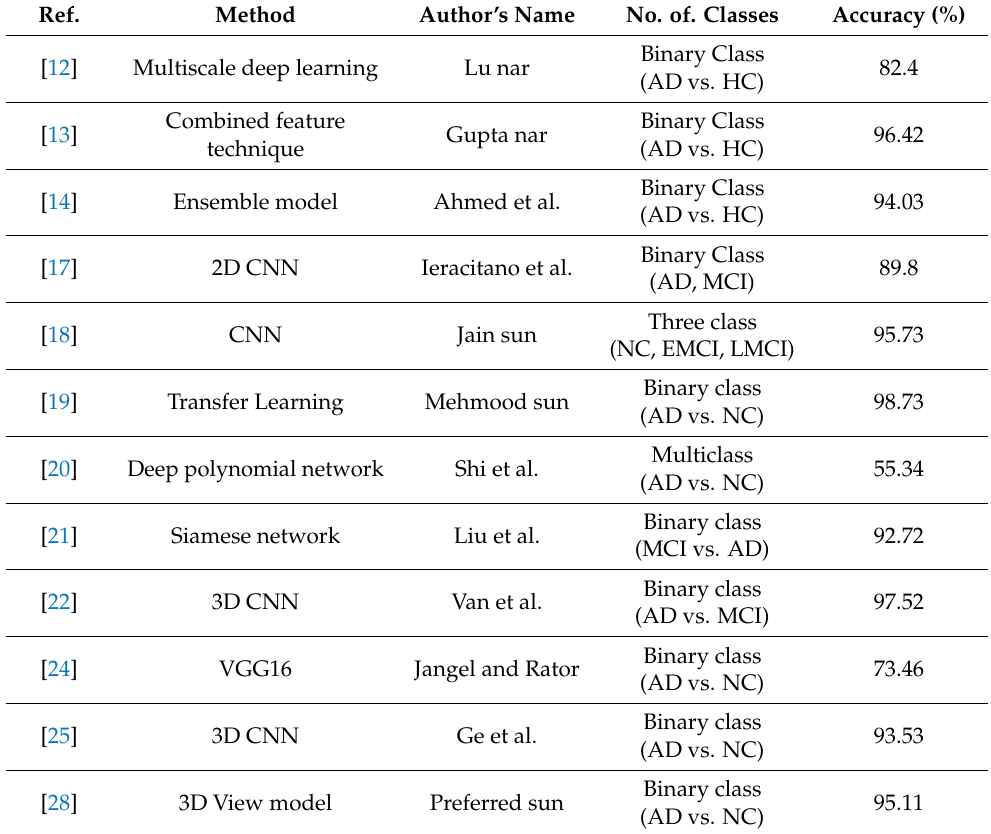
Table 1. A summary of the literature survey.